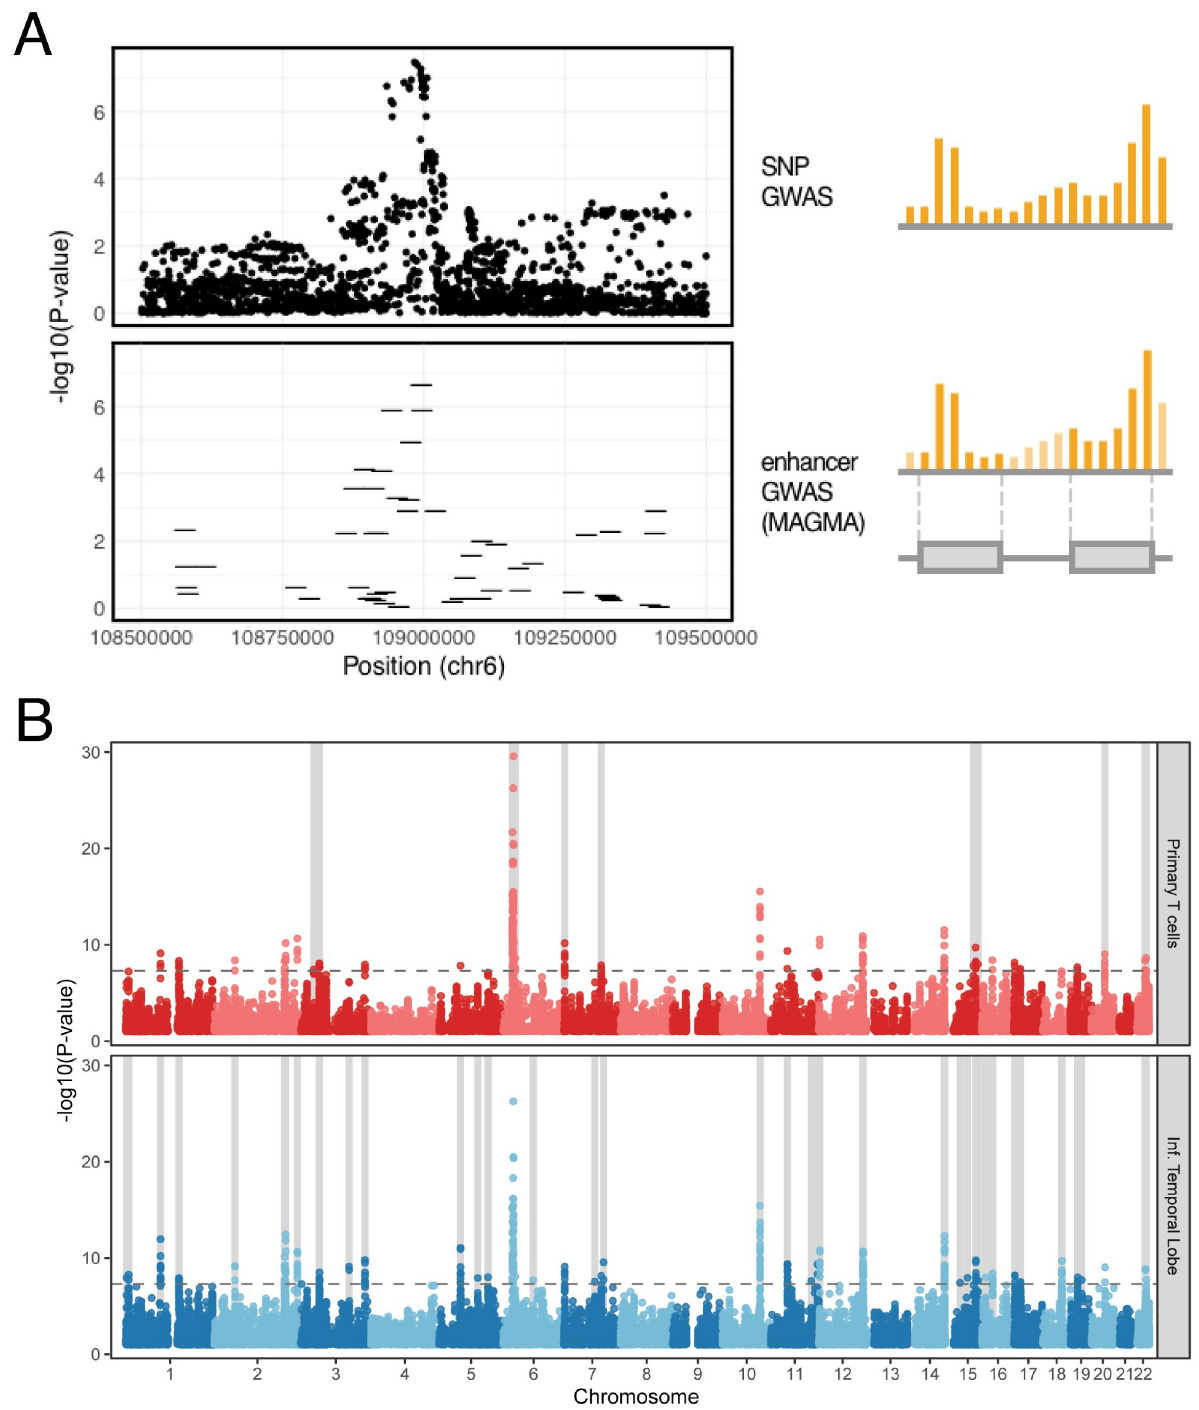
Fig 4. Identification of brain-expressed enhancers associated with genetic risk for schizophrenia. A) Enhancer-based GWAS allows the aggregation of non-coding SNPs into nearby enhancer regions and captures risk loci as enhancer-level risk associations. Individual points on the top panel denote SNPs, while the lines on the bottom panel represent enhancer regions. B) Brain enhancers capture risk loci missed by enhancers from other tissues. Enhancers from primary T cells captured fewer genome-wide significant signals when compared to enhancers from the inferior temporal lobe of the adult brain. The light gray shaded areas denote loci where a given enhancer annotation has more genome-wide significant enhancers when compared to the other annotation.